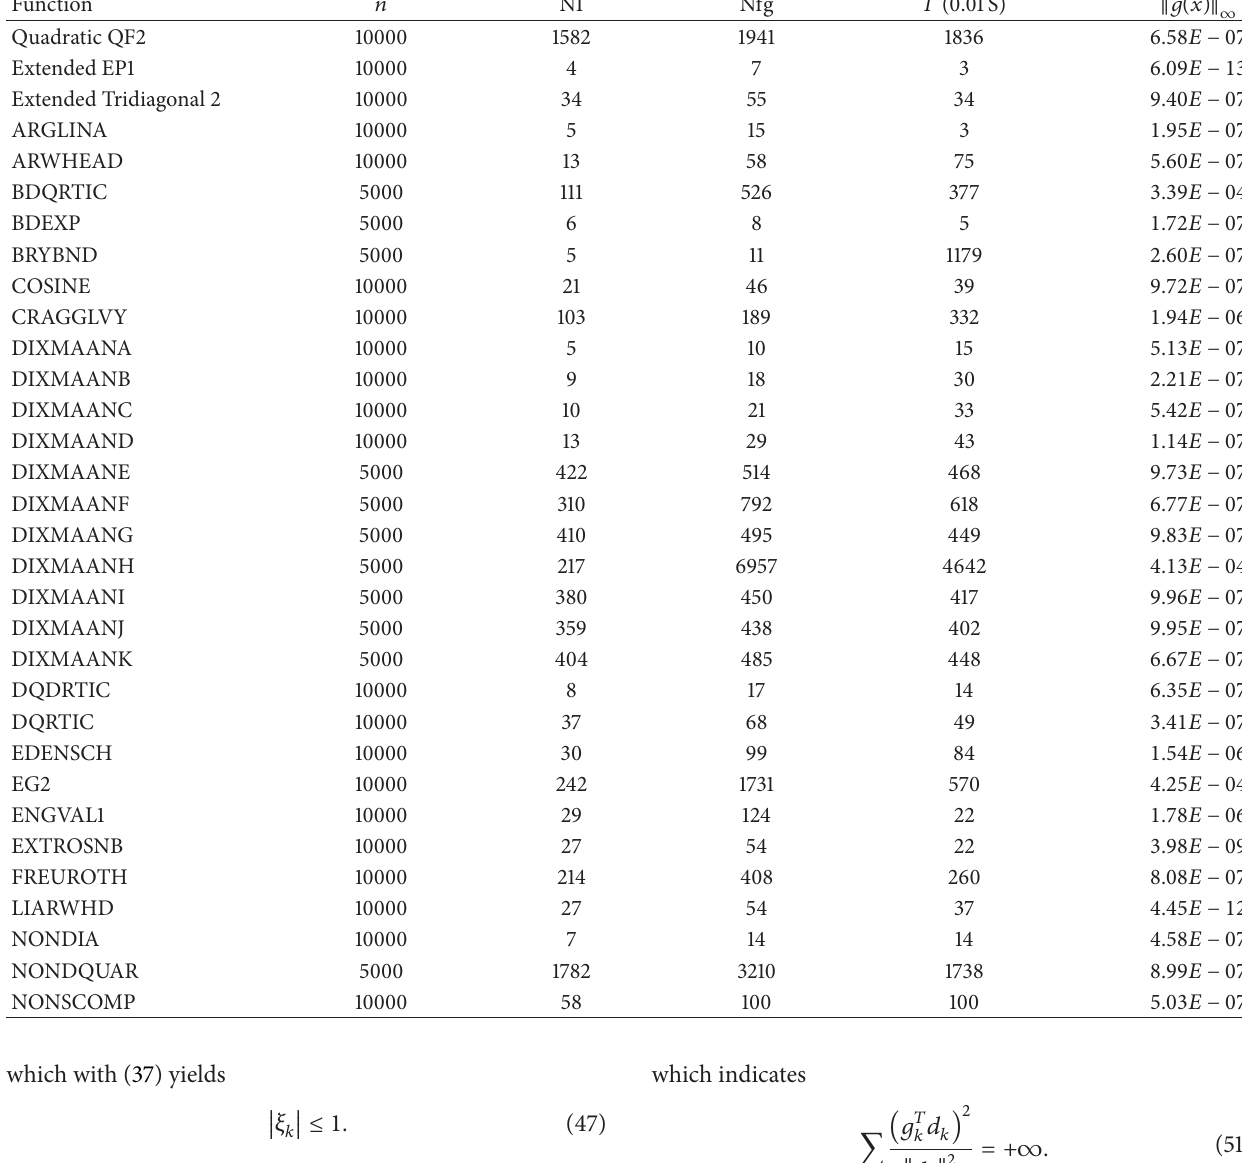
Table 3: Numerical results for S-HSDY